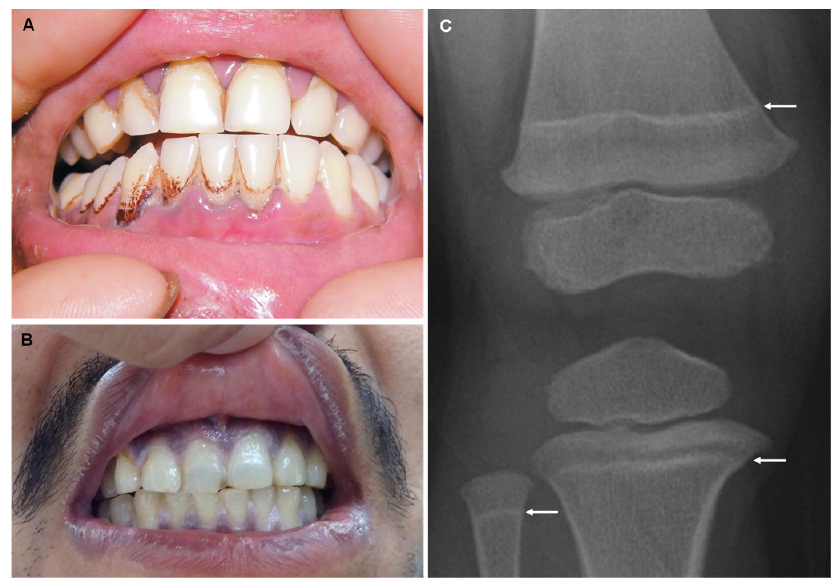
Figure 3. Characteristic Burton’s lines are highlighted by the deposits ( A ) and blue ‐ purplish discoloration of the gums ( B ). X ‐ ray with arrows showing “lead lines” ( C ). Reprinted from ( A )—[94], ( B )—[95], ( C )—[96].